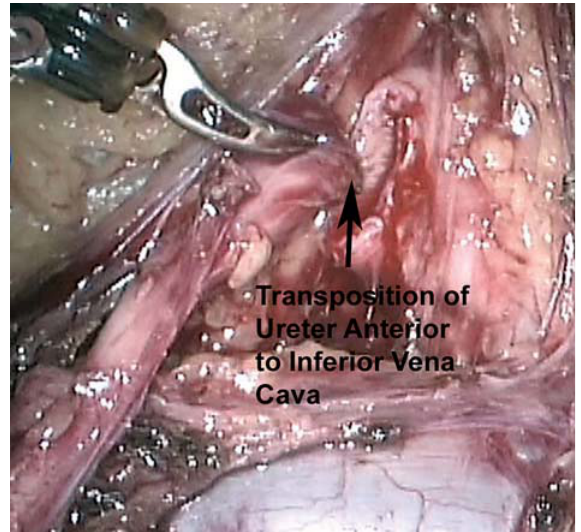
Figure 5 – Transposition of ureter.